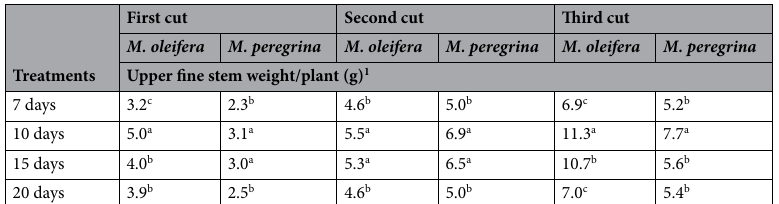
Table 3. The effect of irrigation frequency on upper fine stem weight of M. oleifera and M. peregrina at different cutting periods. 1 Means within each column with the same superscripts were not significantly different using Duncan Multiple Range Test at the 0.05 level of